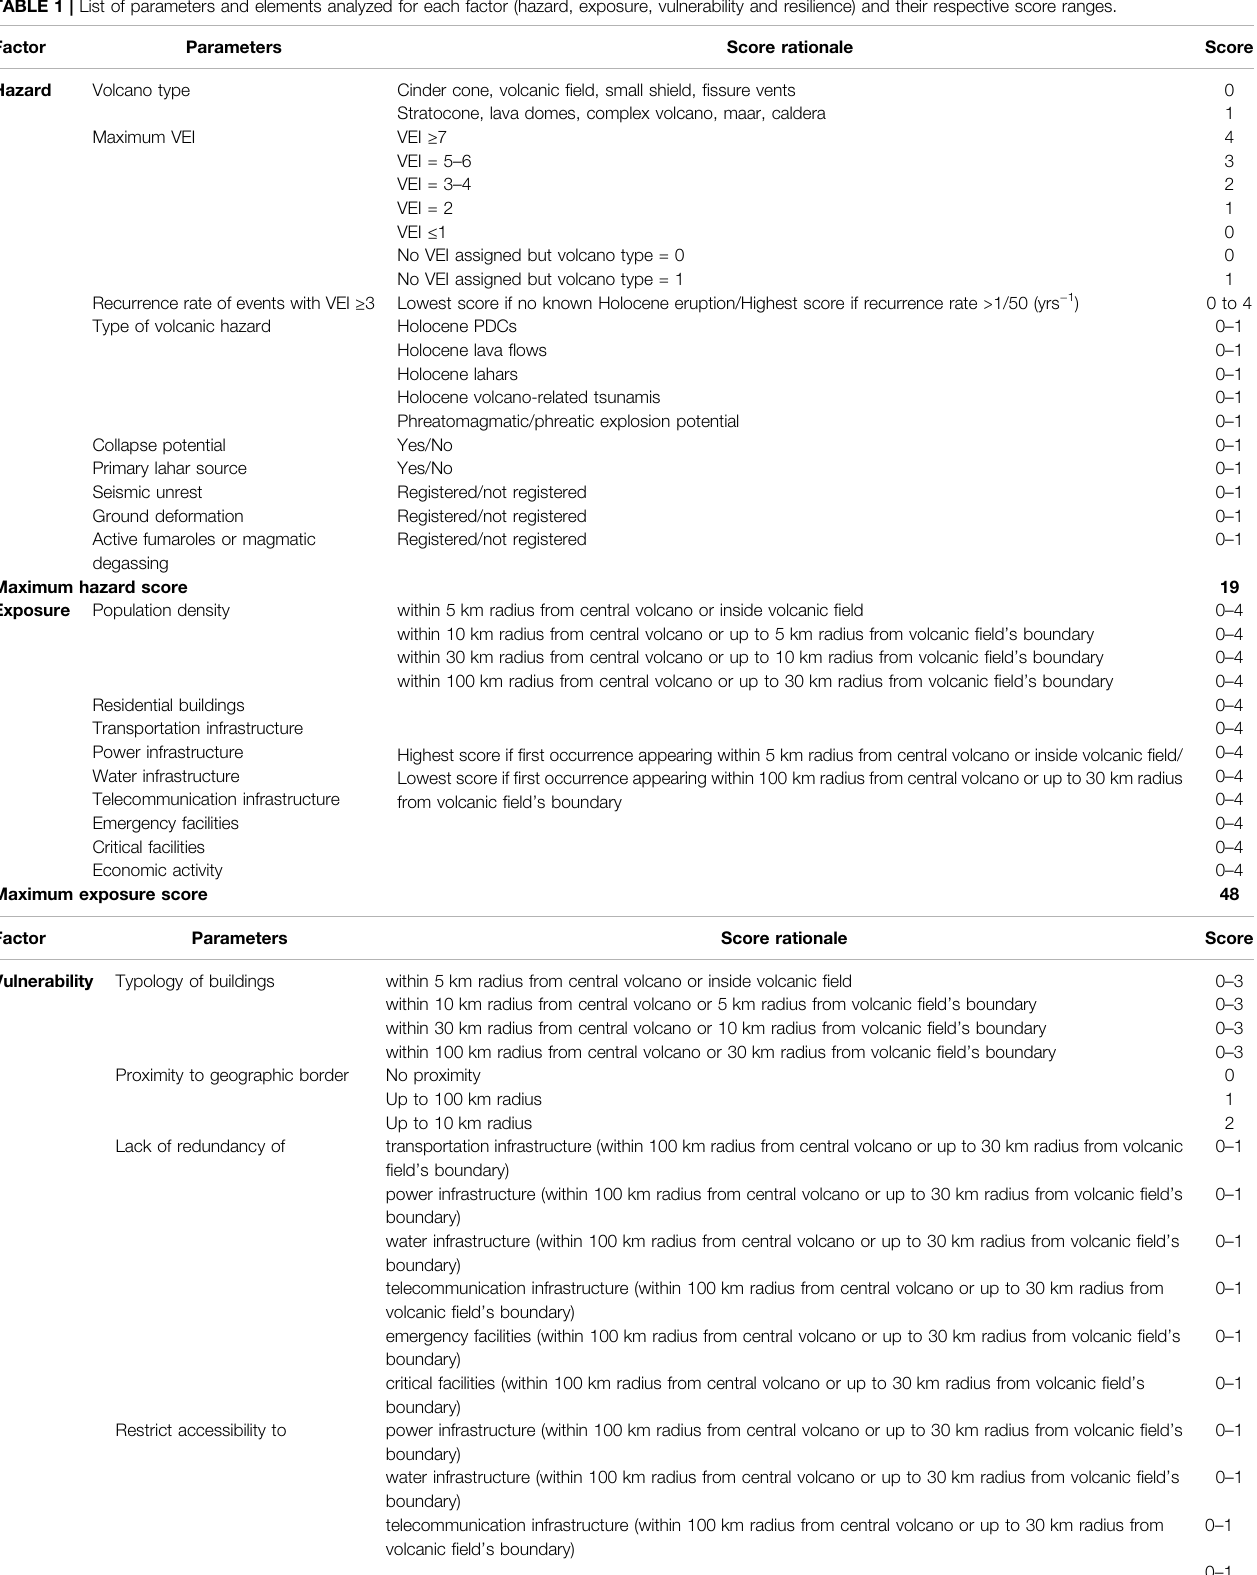
TABLE 1 | List of parameters and elements analyzed for each factor (hazard, exposure, vulnerability and resilience) and their respective score